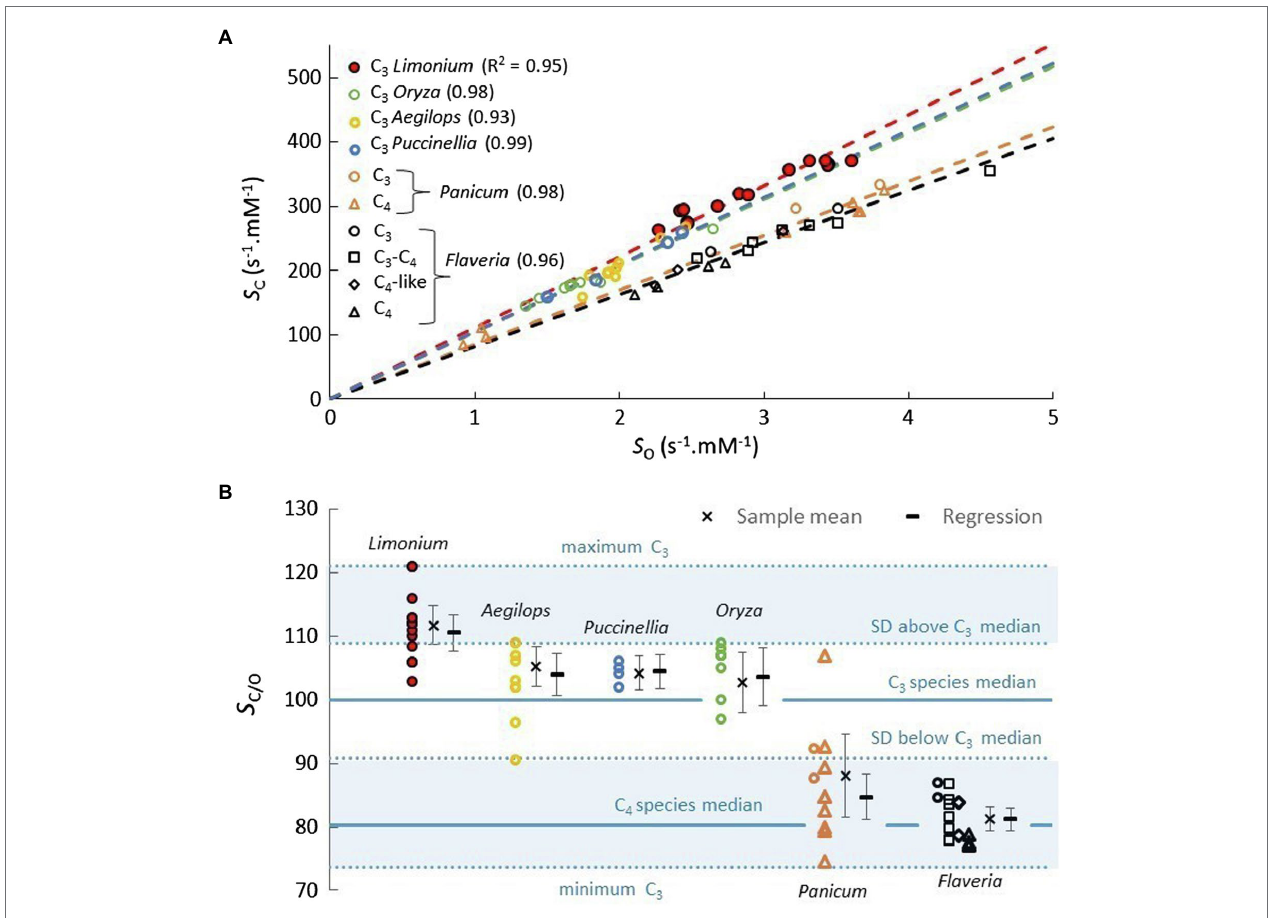
FIGURE 4 | (A) Plots of S C vs. S O for genera with lines of best fit passing through S C = 0. (B) Diagram illustrating the variance of S C/O . The sample means are well approximated by the gradients (regression coefficient) of the trend lines in (A) . The error bars correspond to 95% ( α = 0.05) confidence intervals. The lower shaded area, less than one SD below the median, represents around 10% of the total C 3 species sample, with a mean S C/O of 83.4 ( V C = 2.85 s −1 , K C = 12.1 μM, S C = 245 s −1 . mM −1 ,